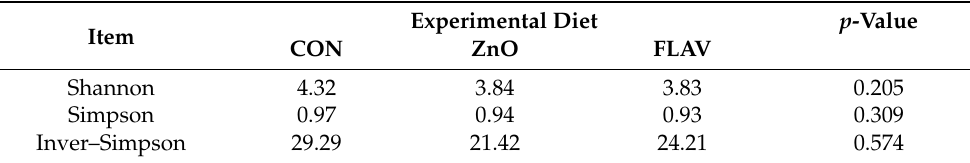
Table 5. Evenness and diversity of colon microbiota of weaned pigs fed experimental diets 1 .